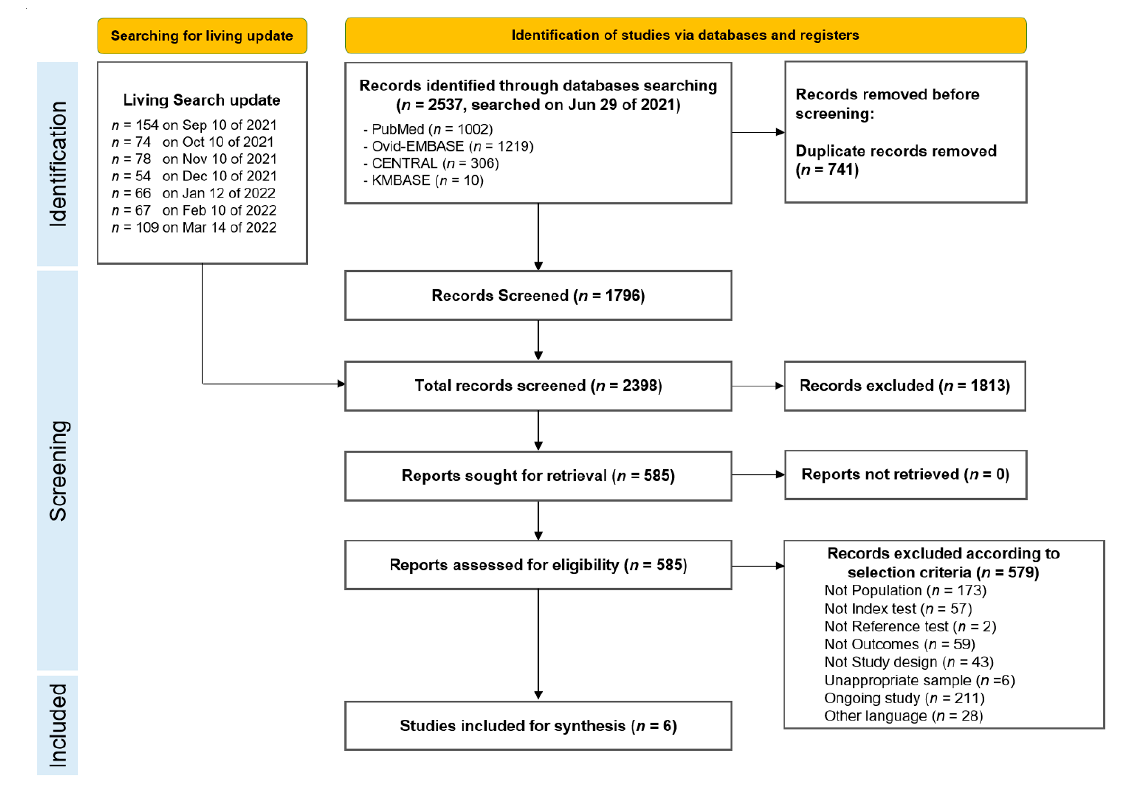
Figure 1. The preferred reporting items for systematic review and meta-analysis (PRISMA) flow diagram.